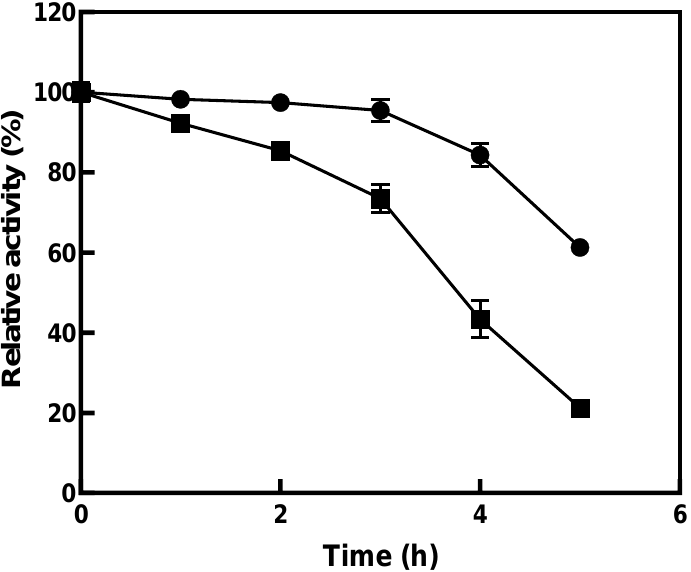
Figure 3. Thermal inactivation of L -arabinose isomerase from K. pneumoniae (closed square) and E. coli cells expressing the enzyme (closed circle) . L -Arabinose isomerase or E. coli cells were incubated at 40 °C or 50 °C, respectively, withdrawn at each time point, and assayed in 50 mM phosphate buffer (pH 8.0) containing 0.8 U/mL enzyme or 1 g/L cells and 50 mM or 20 g/L D -galactose at 40 °C or 50 °C, respectively, for 10 min. Data represent the mean of values from three experiments, and error bars represent standard deviation.